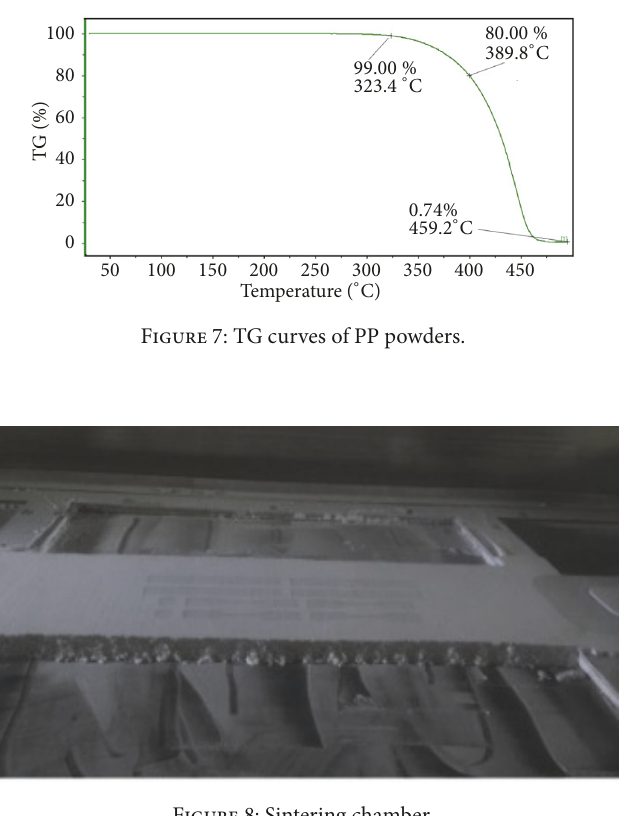
Figure 8: Sintering